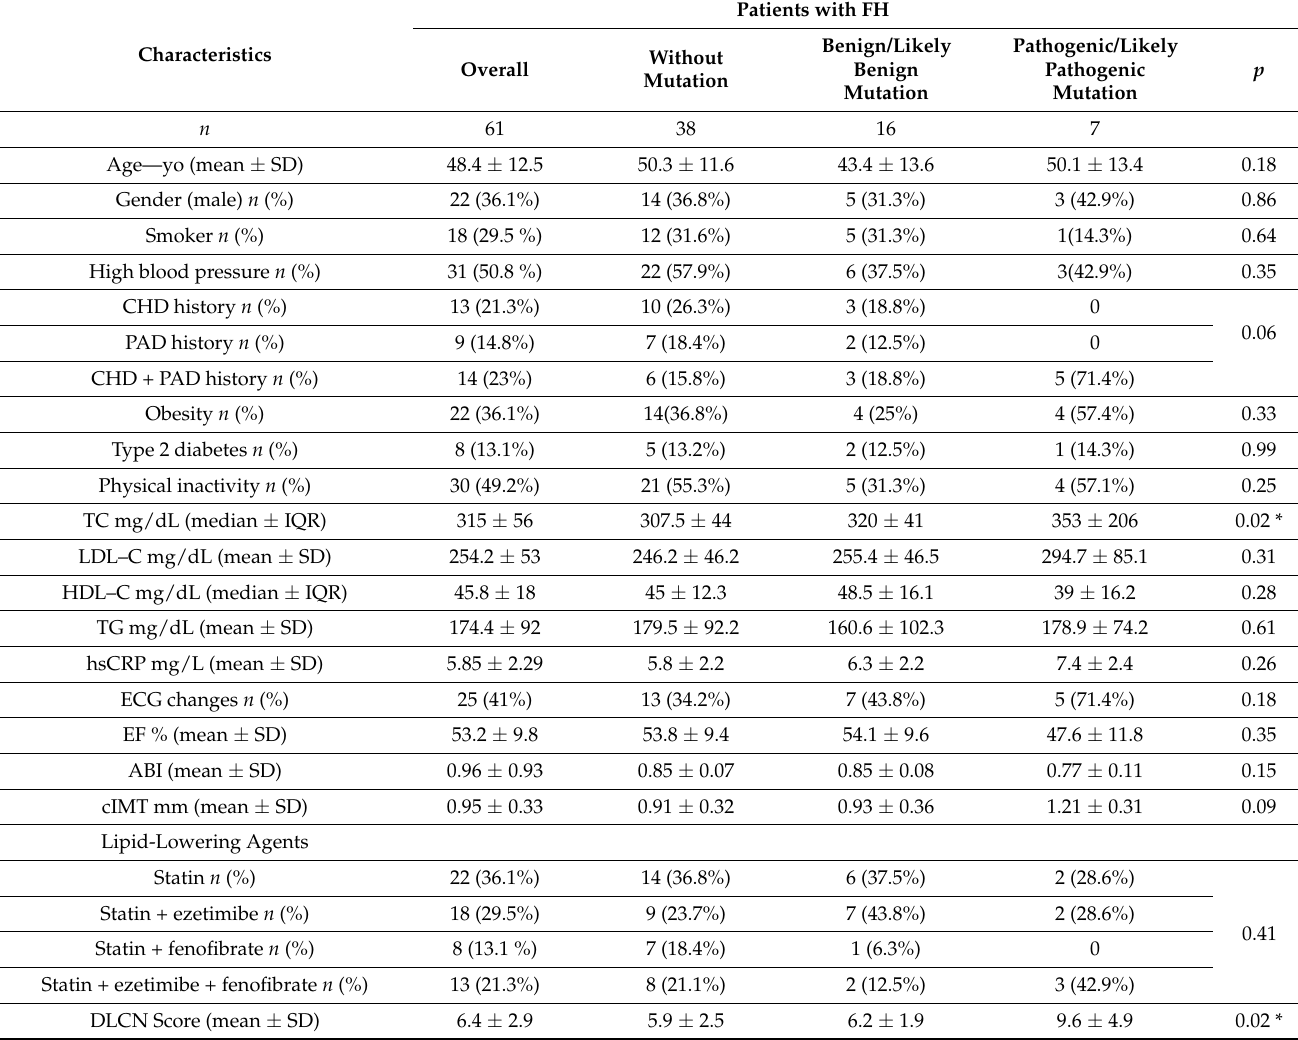
Figure 1. The Sanger sequencing electropherogram in patients H19, H46, and H53: pathogen mutation of LDLR in exon 11 (c.1618G > A). Table 1. Baseline characteristics of familial hypercholesterolemia (FH)